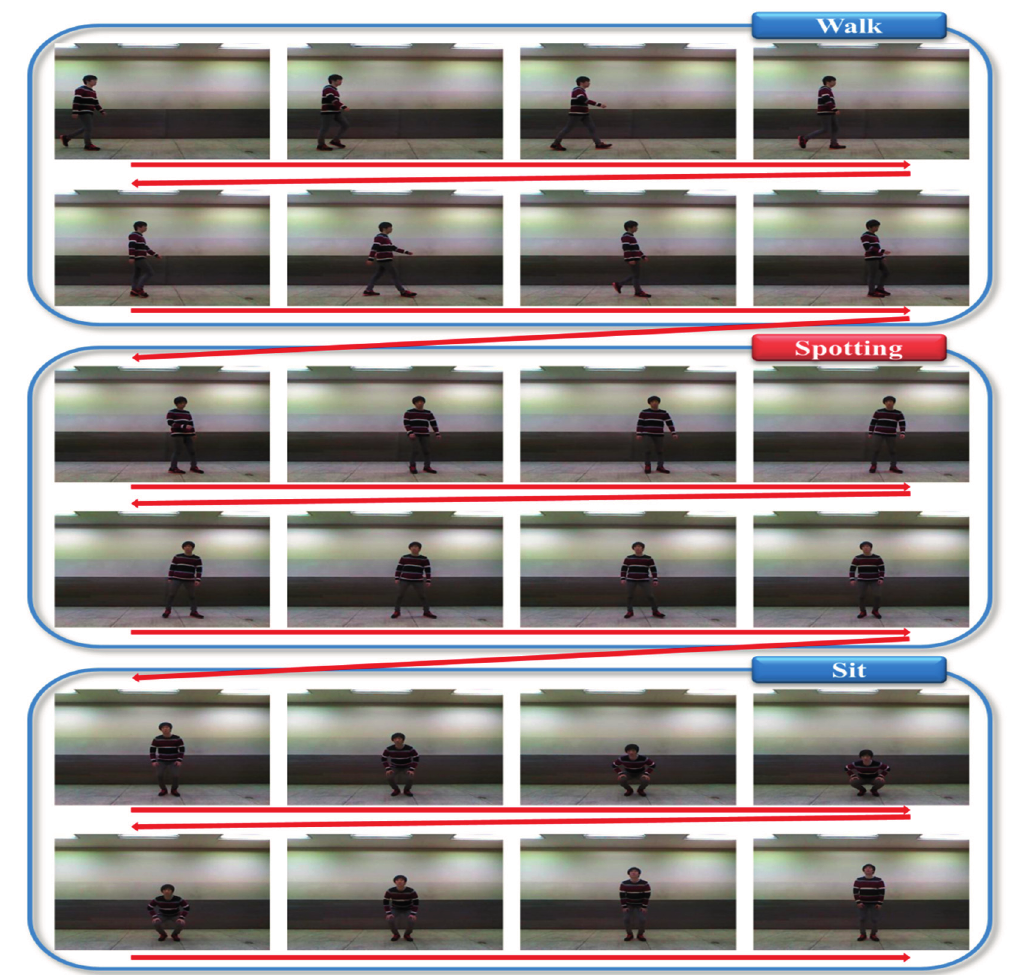
Figure 19. Experimental spotting of continuous action